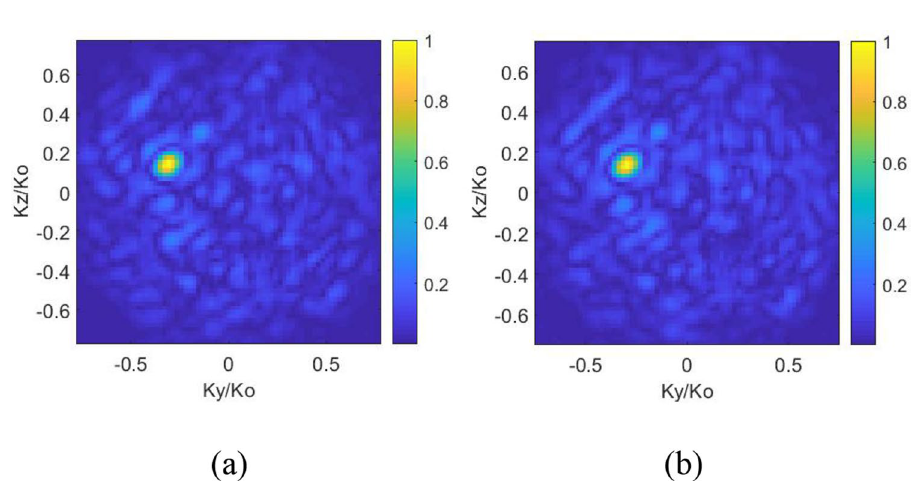
Figure 10. Retrieved DoA patterns of case 4: ( θ = 20°, φ = − 20°) ( a ) when the far-field source spectrum is frequency independent, i.e. 28 GHz, (b) when the far-field source is frequency-dependent (27–29